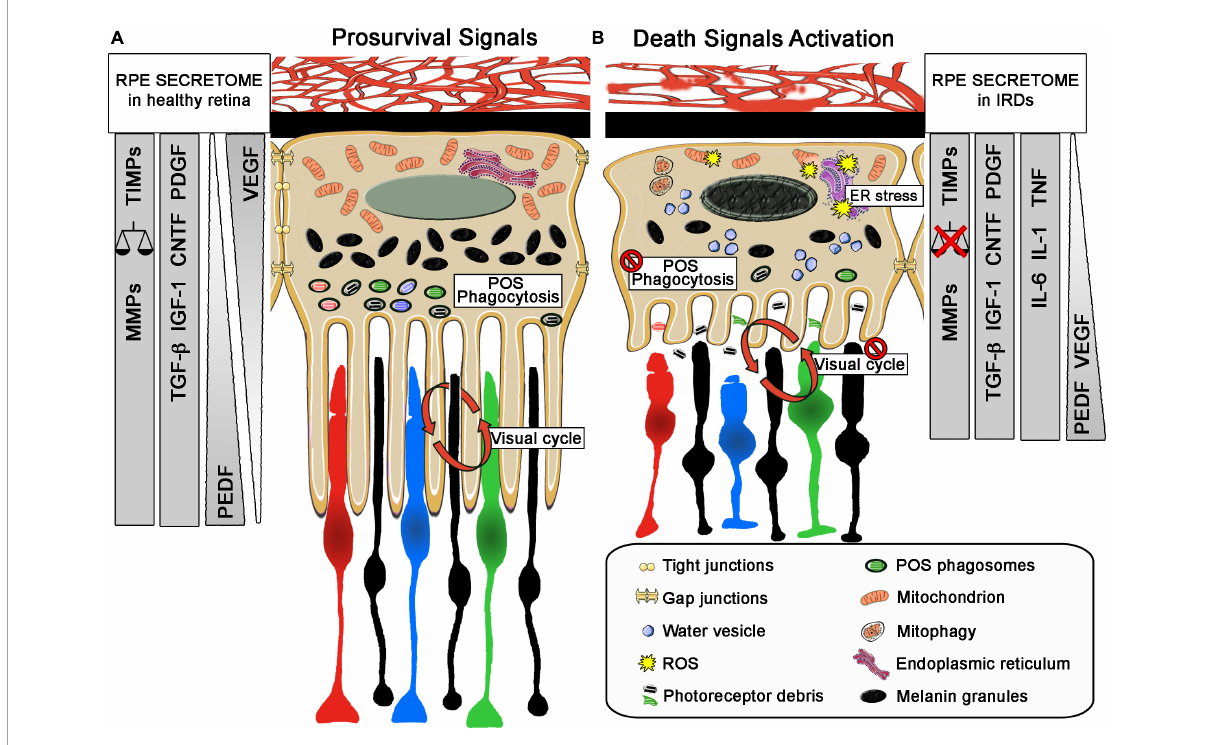
FIGURE3 Role of retinal pigment epithelium (RPE) in IRDs. Schematic representation of main morphology and secretome profile changes of the relationship between RPE and photoreceptors in healthy retina and during retinal degeneration. (A) In healthy retina, RPE exert critical roles related to photoreceptor survive, as phagocytosis of photoreceptor outer segments (POS), visual cycle and forming the outer blood-retinal barrier and secreting neurotrophic factor such as VEGF from the basolateral to apical part of the RPE cell. In addition, the selective secretion